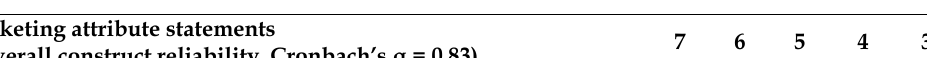
Descriptive analysis of the survey